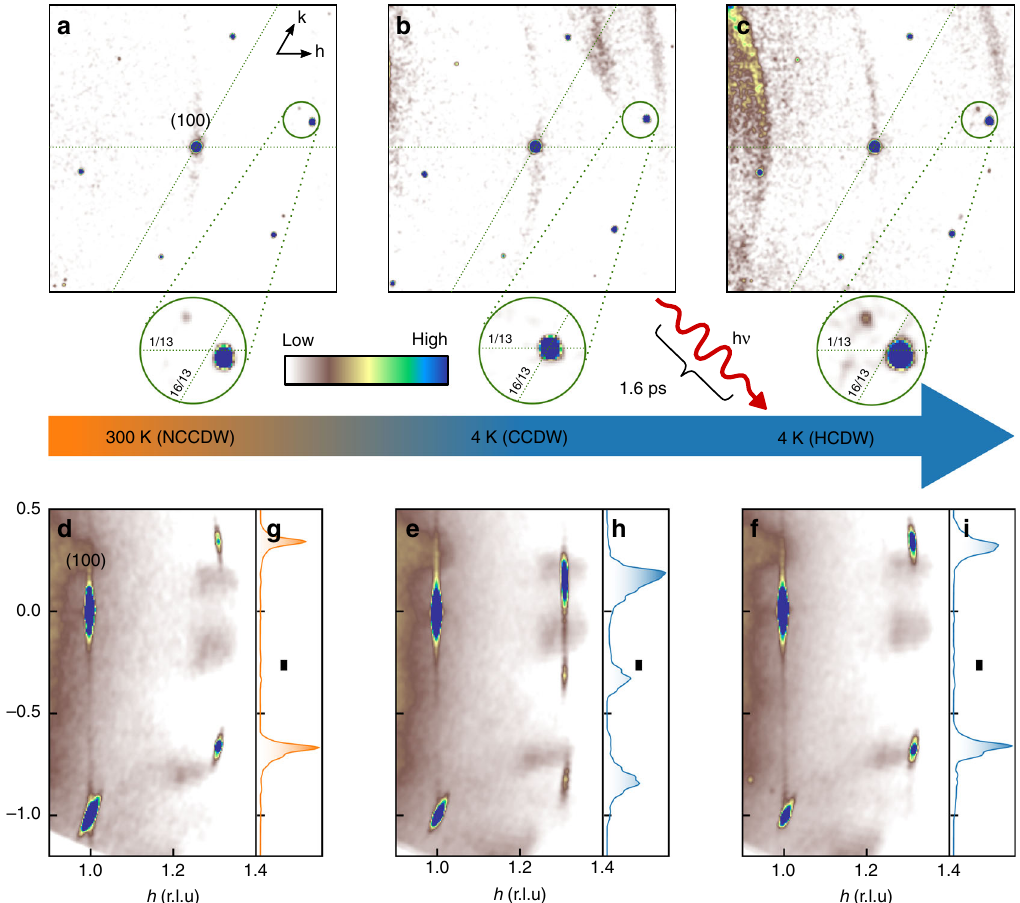
Fig. 2 Photo-induced changes of the XRD from a thin fl ake of 1T-TaS 2 . Reciprocal space maps parallel to the hk 0-plane (integration thickness perpendicular to the plane: δ l = 2 ∕ 3 r.l.u.) for the NCCDW at room temperature ( a ), the CCDW at T = 4 K ( b ) and the photo-induced HCDW at the same temperature T = 4 K. The characteristic occurrence of strong higher-order superlattice re fl ections due to the in-plane discommensurations network is clearly observable for the NCCDW ( a ) and the HCDW ( c ). Reciprocal space maps parallel to the h 0 l -plane (integration thickness perpendicular to the plane: δ k = 0.3 r.l.u.) are shown in d – f for NCCDW, CCDW, and HCDW, respectively. The extracted intensity distribution of the superlattice re fl ections along the l -direction clearly shows the well-de fi ned sharp spots for the NCCDW ( g ), the characteristic diffuse double-peak feature for the CCDW ( h ) and the vanishing of the diffuse scattering for the photo-induced HCDW. The black bars in g , h , and i indicate the full width at half maximum of a typical Bragg peak. Table 1 Parameters of the in-plane q -vector for CCDW, HCDW, and NCCDW. state σ 1 (r.l.u.) σ 2